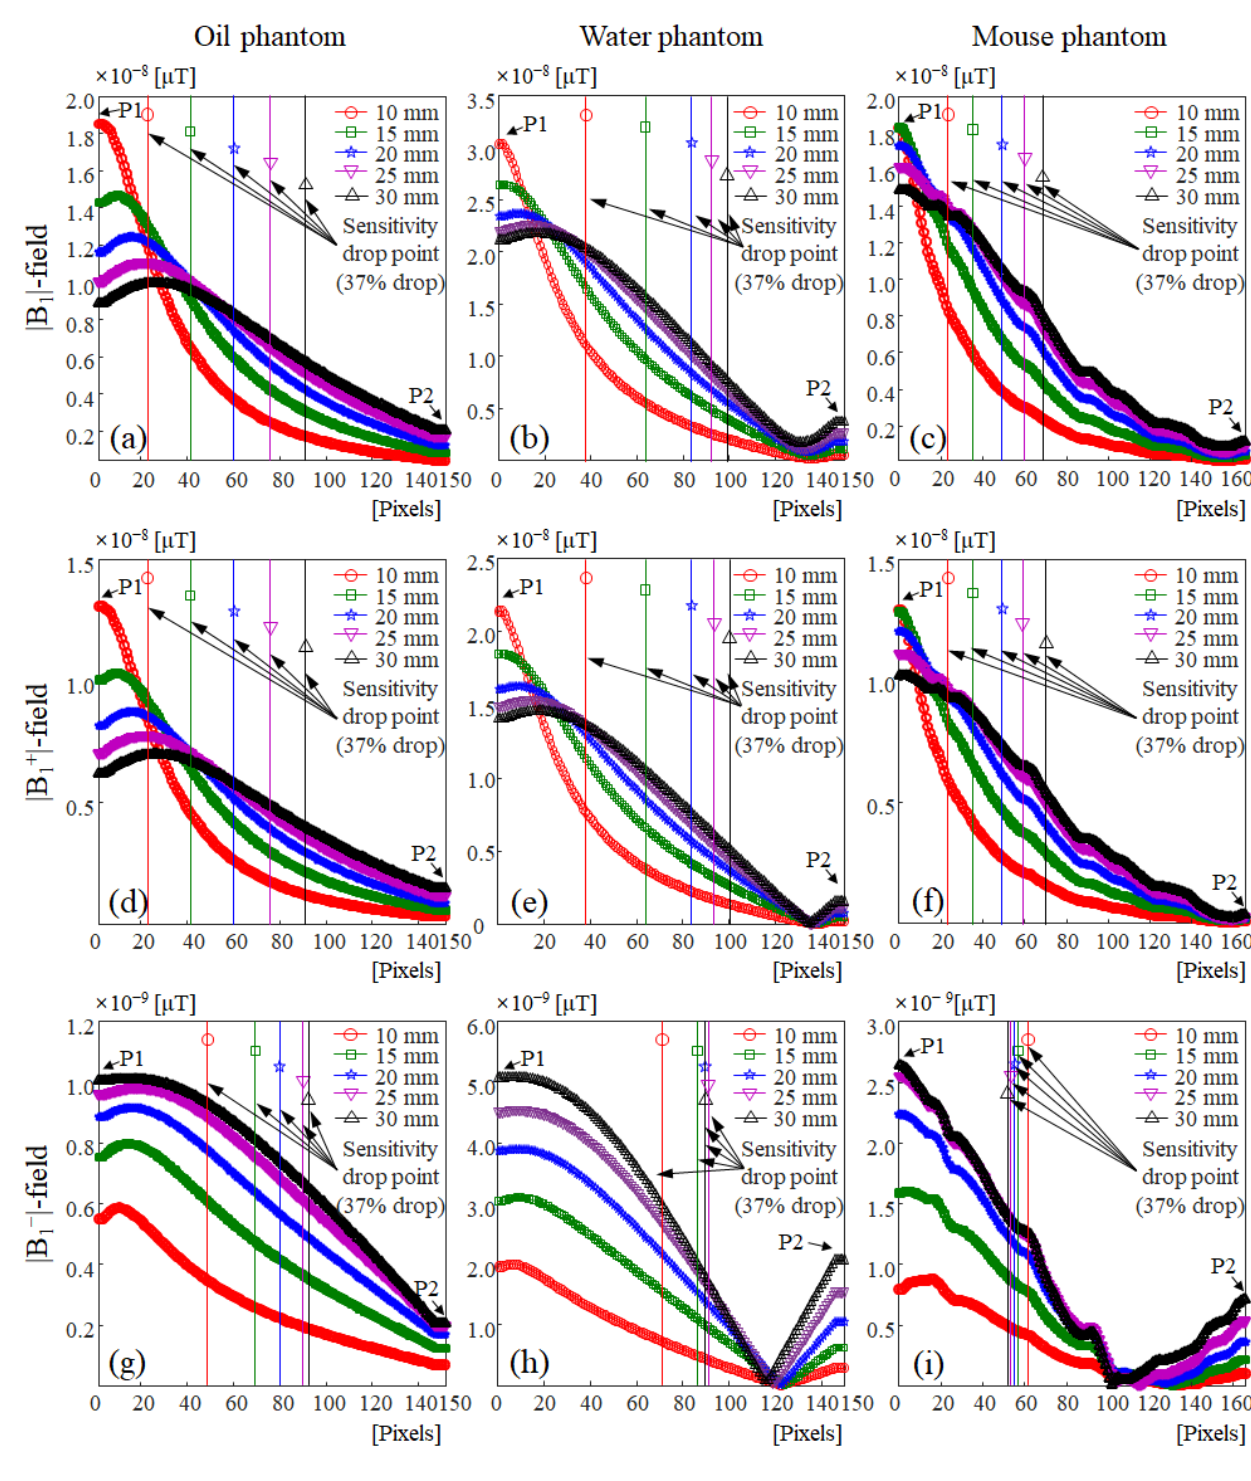
Figure 5. Center slice profile (from P1–P2) of |B 1 |-, |B 1+ |-, and |B 1 − |-field using oil phantom, water phantom, and mouse phantom: ( a ) center slice profile of |B 1 |-field using oil phantom, ( b ) center slice profile of |B 1 |-field using water phantom, ( c ) center slice profile of |B 1 |-field using mouse phantom, ( d ) center slice profile of |B 1 + |-field using oil phantom, ( e ) center slice profile of |B 1 + |-field using water phantom, ( f ) center slice profile of |B 1 + |-field using mouse phantom, ( g ) center slice profile of |B 1 − |-field using oil phantom, ( h ) center slice profile of |B 1 − |-field using water phantom, ( i ) center slice profile of |B 1 − |-field using mouse phantom.